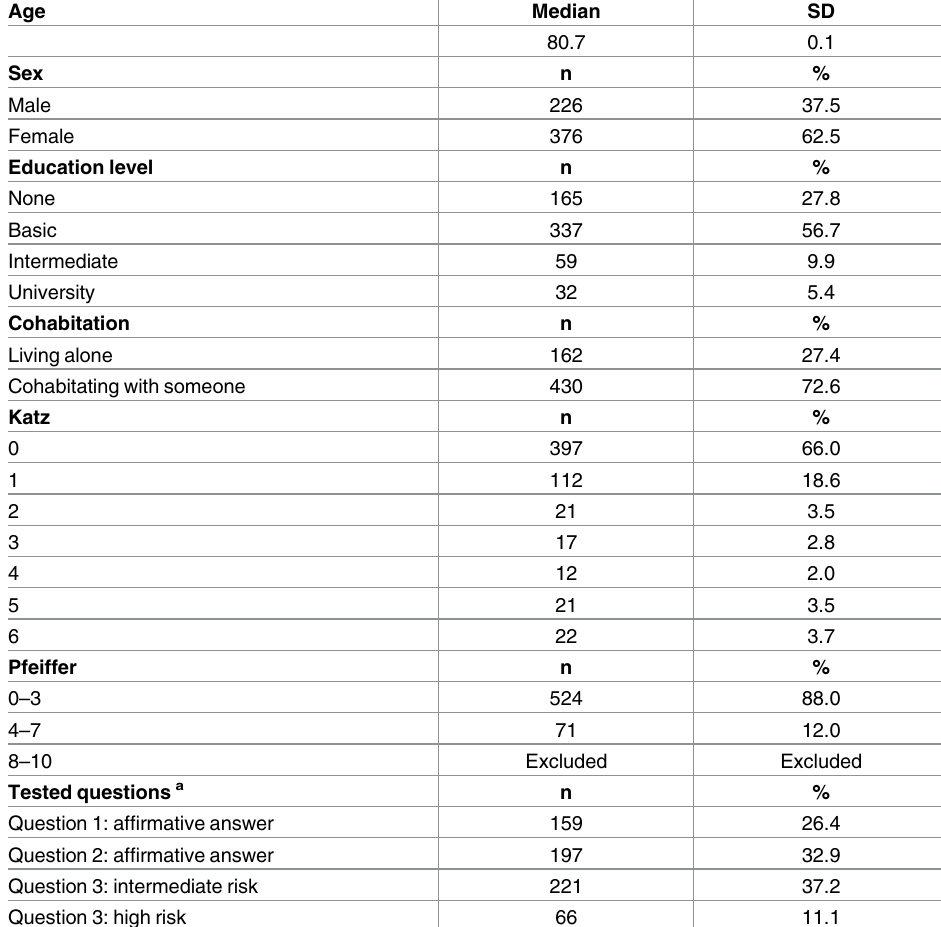
Table 2. Socio-demographic data of participants who completed the first follow-up